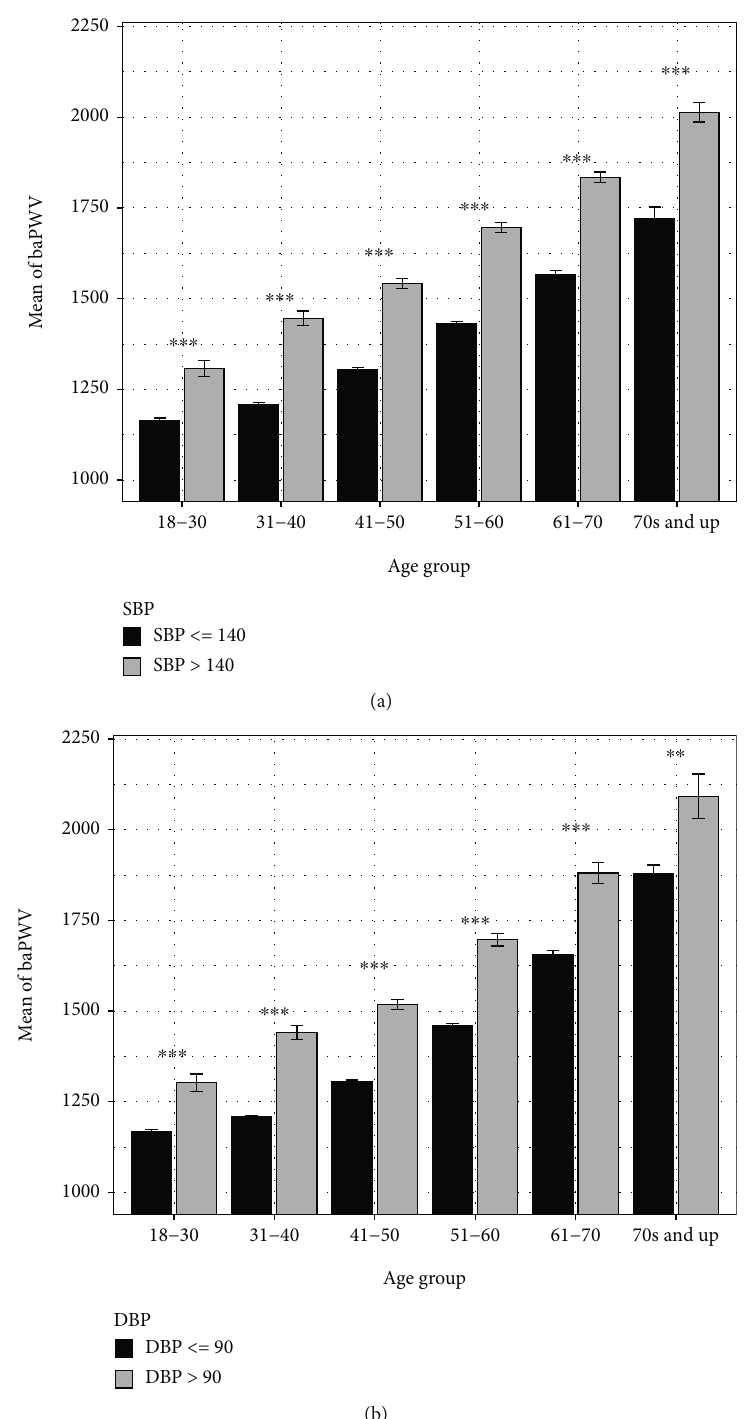
Figure 2: The temporal patterns of baPWV in cohorts with high or low systolic blood pressure (a) and diastolic blood pressure (b). The individuals with raised systolic blood pressure and diastolic blood pressure also exhibited heightened baPWV readings across all age groups. Signi fi cance level: P < 0 : 001 ( ∗∗∗ ), P < 0 : 01 ( ∗∗ ), and P < 0 : 05 ( ∗